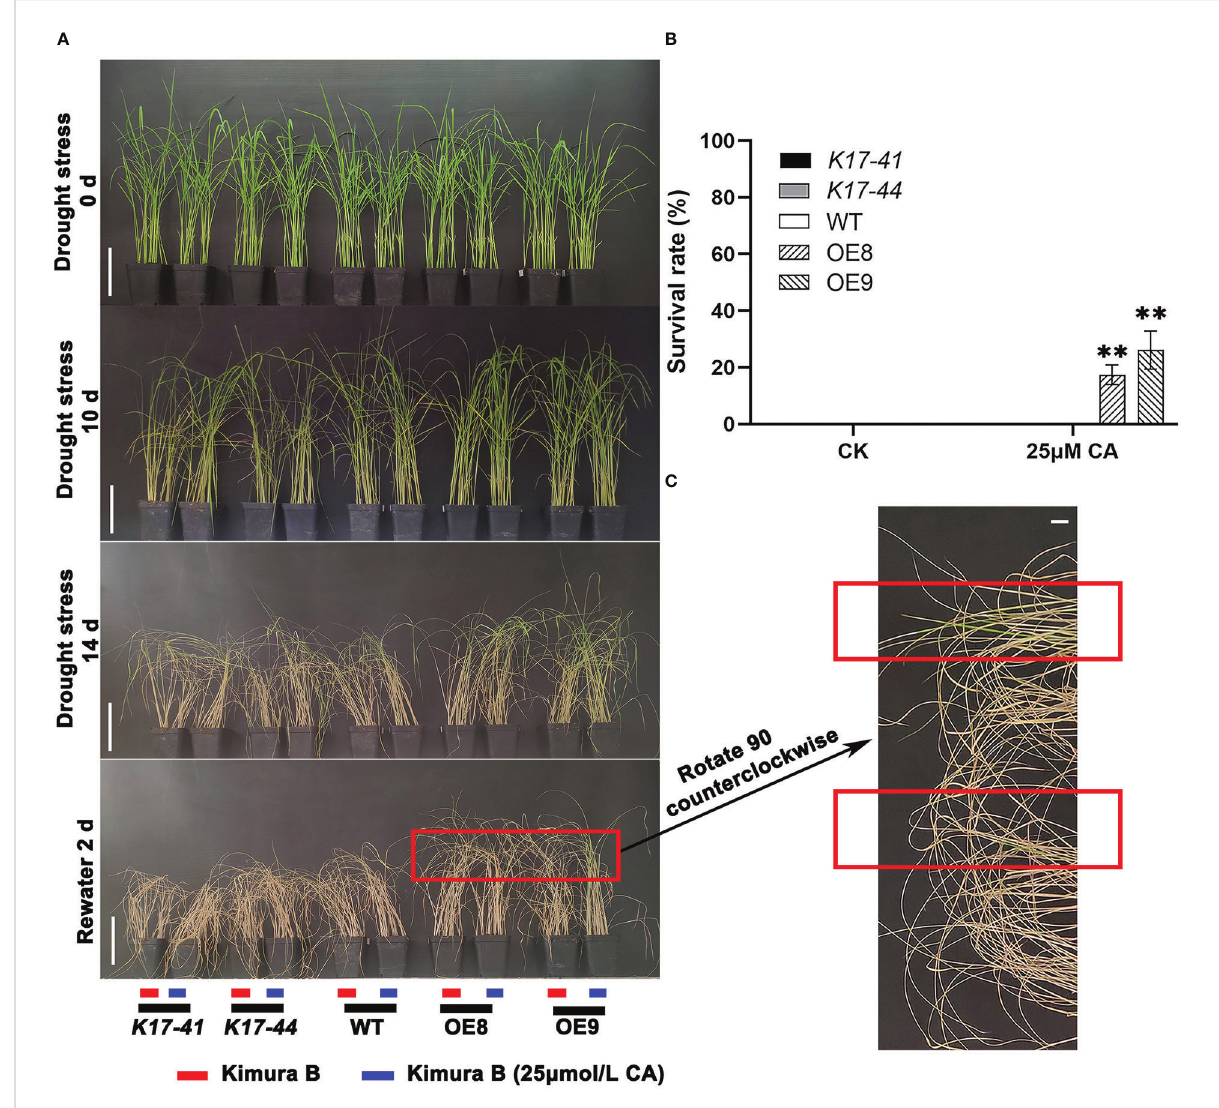
FIGURE 8 Exogenous citric acid treatment enhanced the drought tolerance of OsCIPK17 -OE, while it did not affect OsCIPK17 -Mutant and WT. (A) Twenty- two days after germination, OsCIPK17 -OE, OsCIPK17 -mutant, and WT seedlings were grown in clear water with or without 25 m mol·L -1 . Water isolation treatment was performed on day 23 and watering was stopped, and photographs were taken and recorded at different intervals. The basic number of seedlings per pot is 30. (B) The survival of each strain after rehydration in (A) was counted, and the survival was considered when the leaves were unfolded and green. Survival rate = number of survivors/total number of seedlings. bar = 7cm. (C) It is the magni fi ed fi eld of view of OsCIPK17 -OE surviving seedlings in (A) . bar = 1cm. Data in (B) are presented as mean ± SD of three independent experiments, and signi fi cant differences between CIPK17-OE and WT plants according to one-way ANOVA are indicated by asterisks. Asterisks indicate signi fi cance (**p <